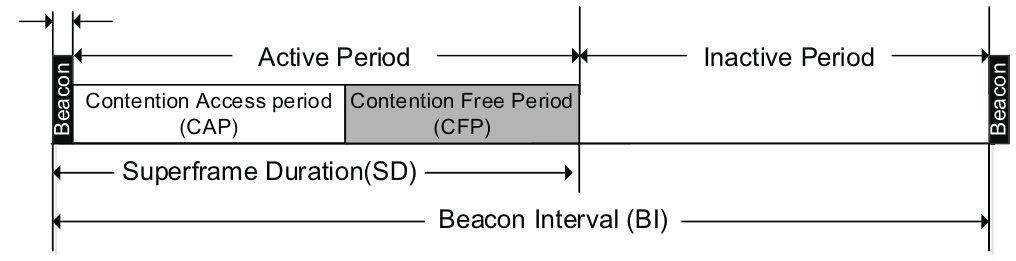
Figure 1. IEEE 802.15.4 Beacon enabled mode Superframe